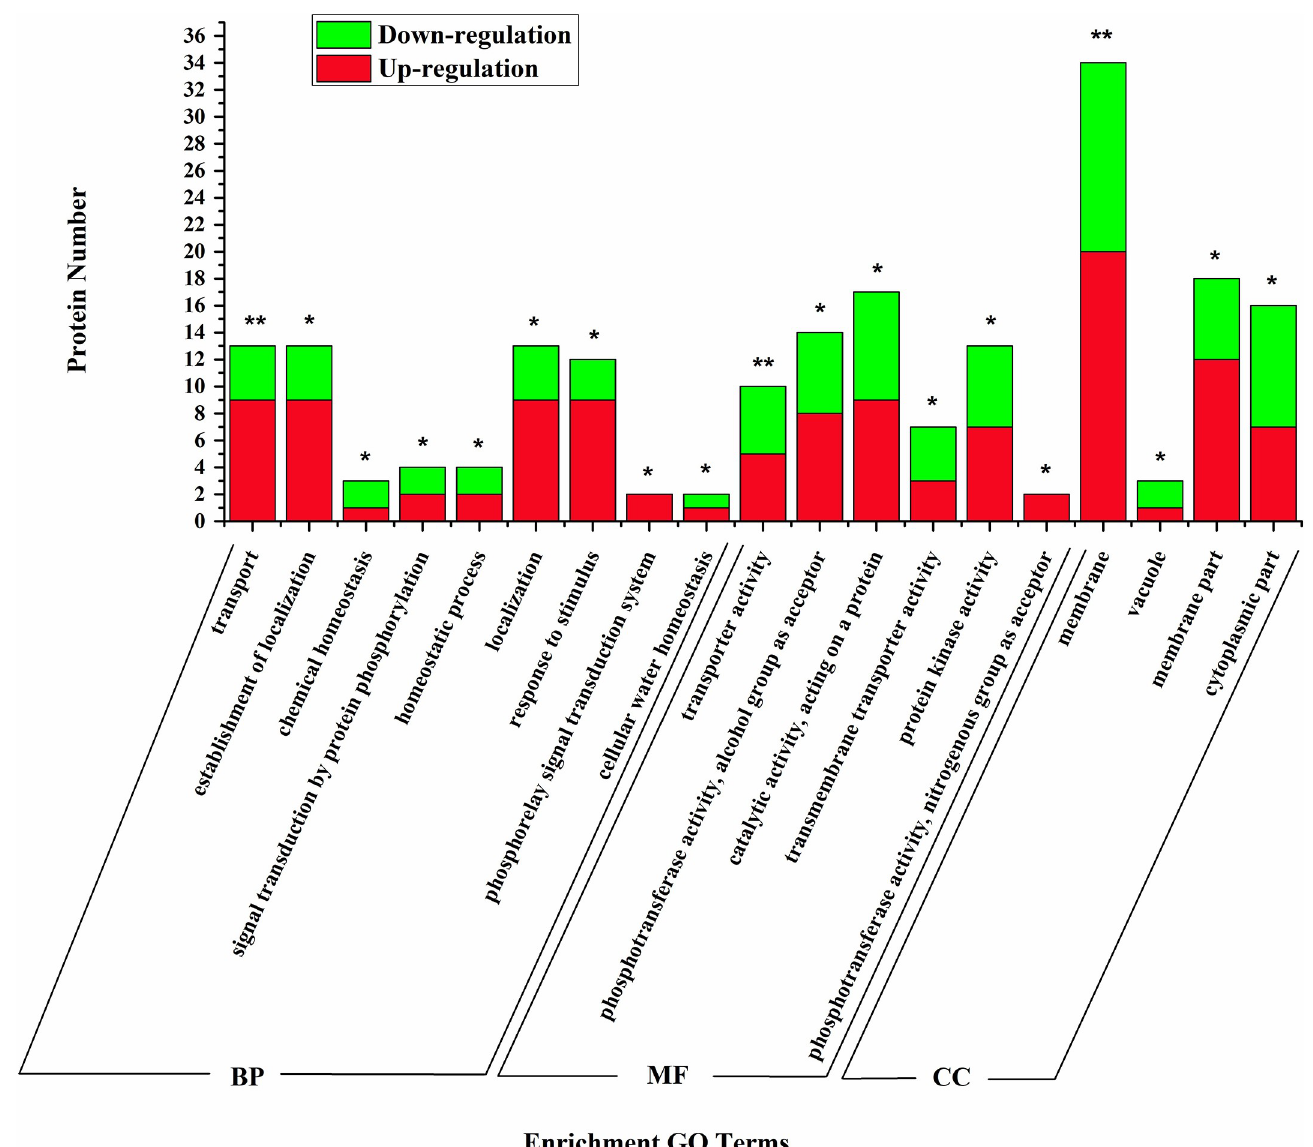
Fig 3. GO enrichment analysis of phosphopeptides with differential